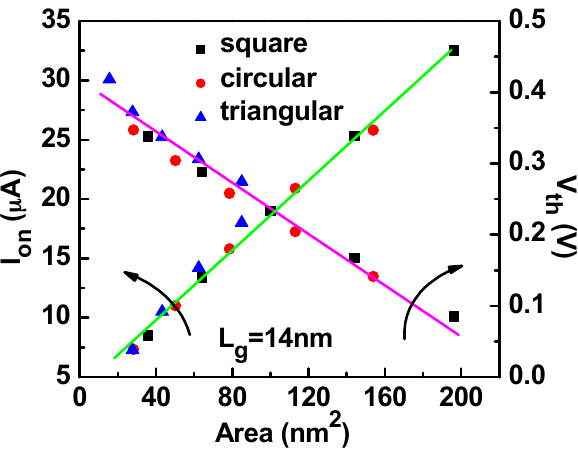
Figure 4. The trends of V th and I on with cross-sectional area in GAA SNWTs. π S square = D 2 , S circle = D 2 , S triangle 4